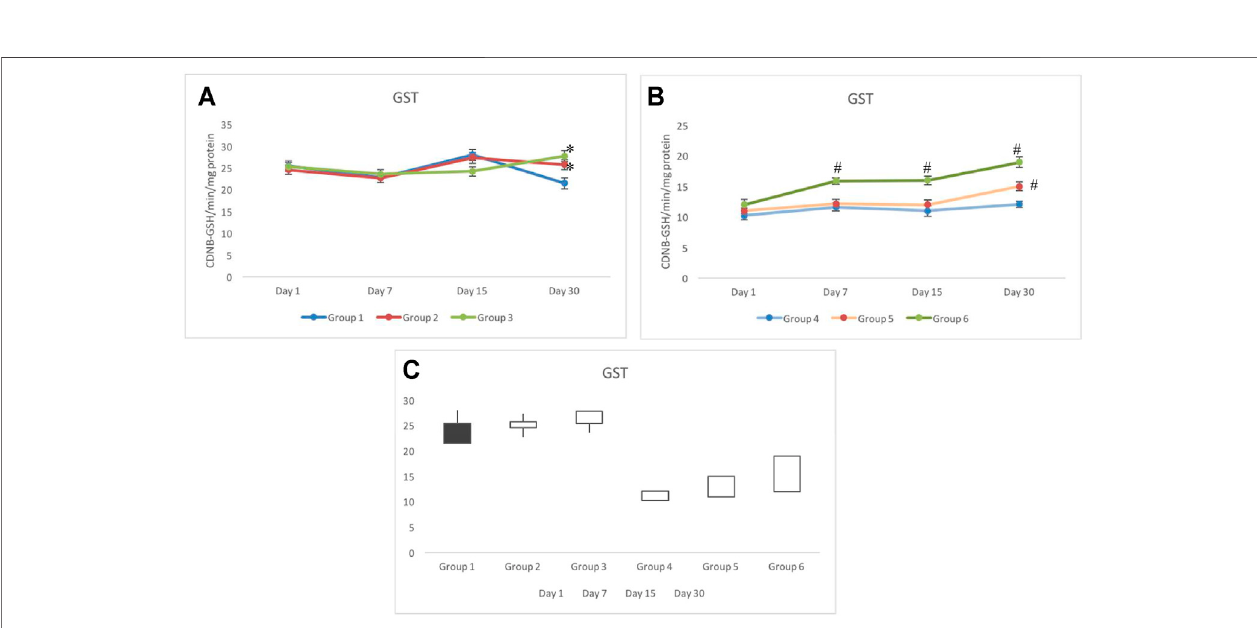
FIGURE 5 | Animals pretreated with CRE/CRE-AgNPs indicated differential activity of glutathione-S-reductase (GST) in non-irradiated (A) and irradiated (B) groups.Changeinactivityfromday1today30wasexpressedintheboxplotwhereblackindicatesthelossofactivityandthewhiteboxindicatesthegaininactivity (C) . * p < 0.05 signi fi cance level was measured against group 1. # p < 0.05 signi fi cance level was measured against group